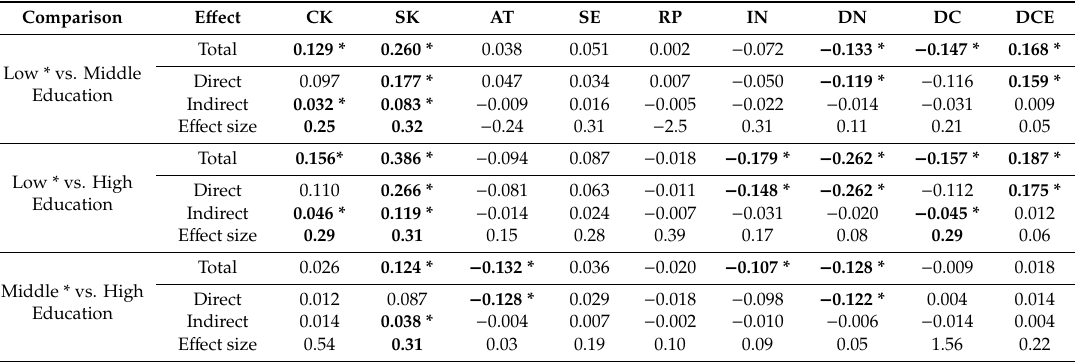
Table 2. Standardized total, direct and total indirect e ff ects: mediator Comprehension . Comparison E ff